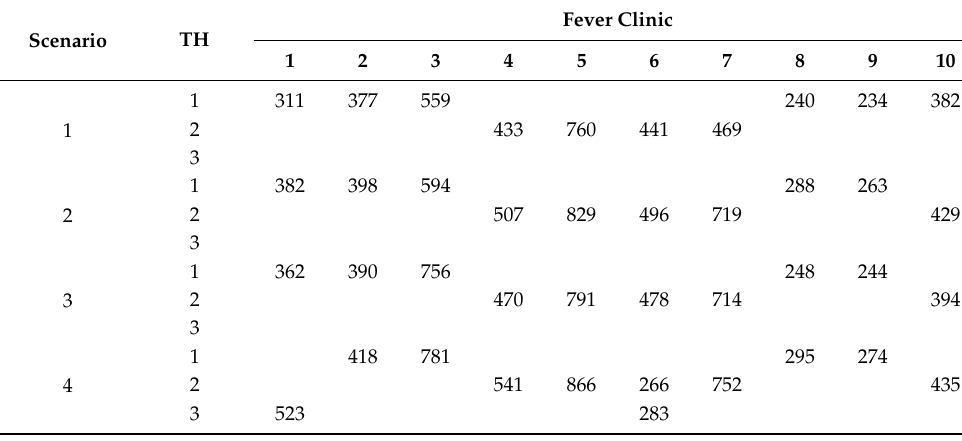
Table 8. Infected people transferred from each fever clinic to established THs.